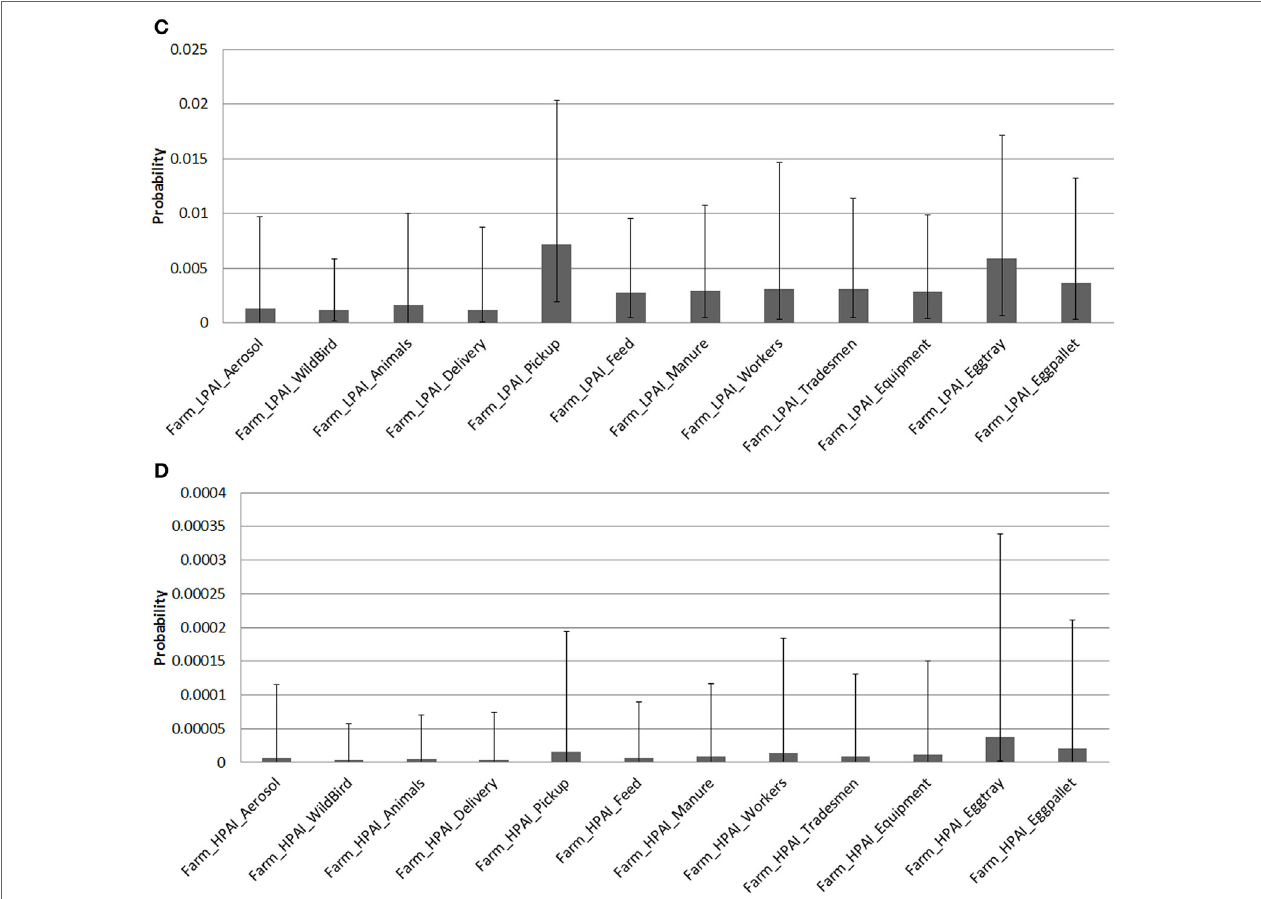
FigUre 4 | Average median (5 and 95 percentiles) probabilities of low-pathogenic avian influenza (LPAI) and high-pathogenic avian influenza (HPAI) spread pathways between sheds and farms of the commercial chicken farm types (barn meat chicken, free range meat chicken, cage layer, barn layer, free range layer) after one chicken is exposed to LPAI in Australia. (a) Average median probabilities of LPAI spread pathways between sheds. Spread_LPAI_Boots , Probability that shed-to- shed spread of LPAI will occur via the movement of boots; Spread_LPAI_Equipment , Probability that shed-to-shed spread of LPAI will occur via the movement